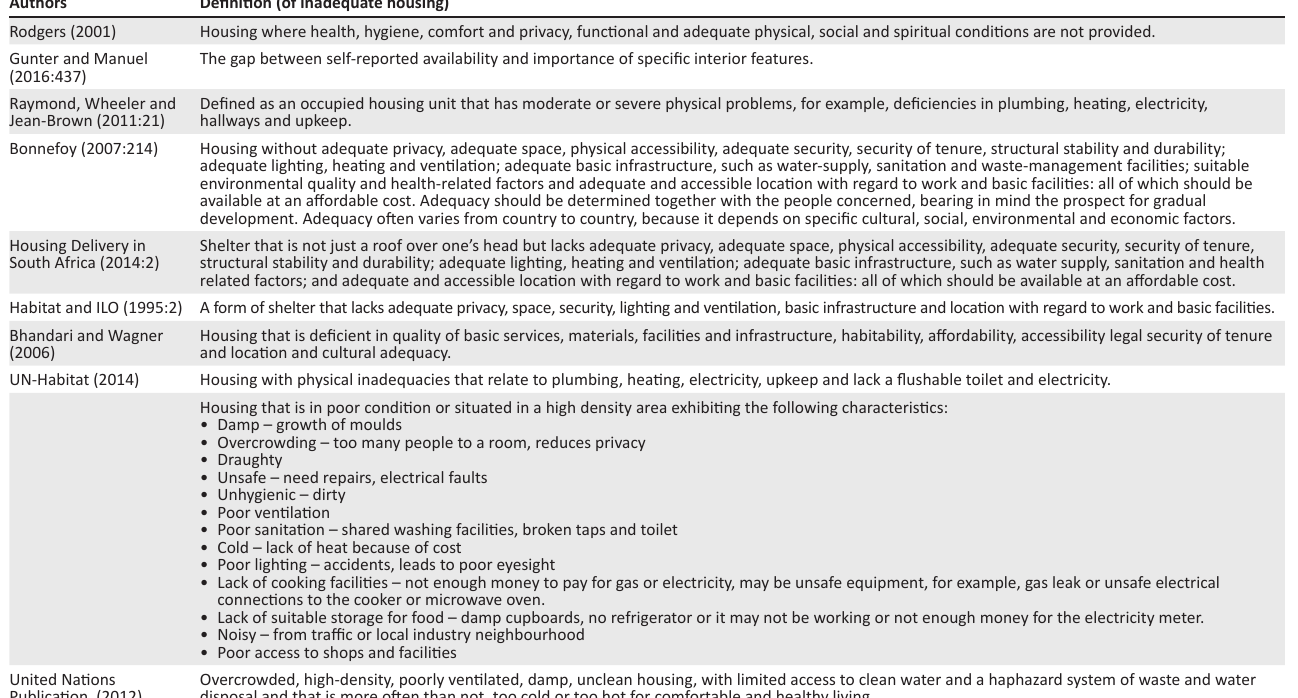
TABLE 1: Definitions of inadequate